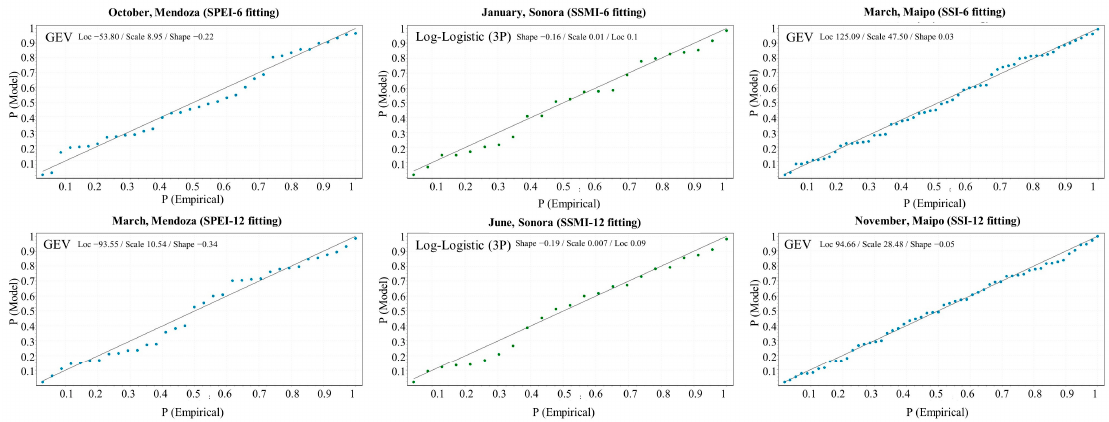
Figure 3. Examples of P-Plots for distribution fitting.